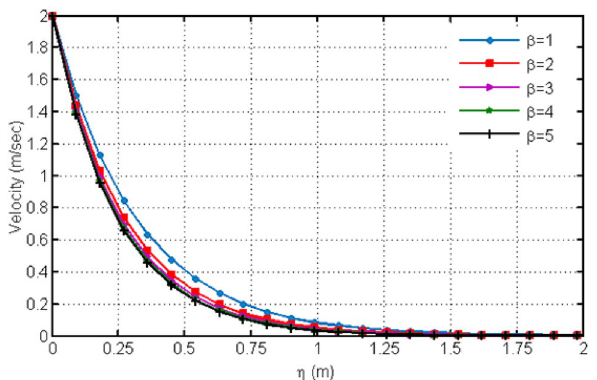
Figure 2. Variation in velocity profile for diverse values of C 6 H 9 NaO 7 parameter β .